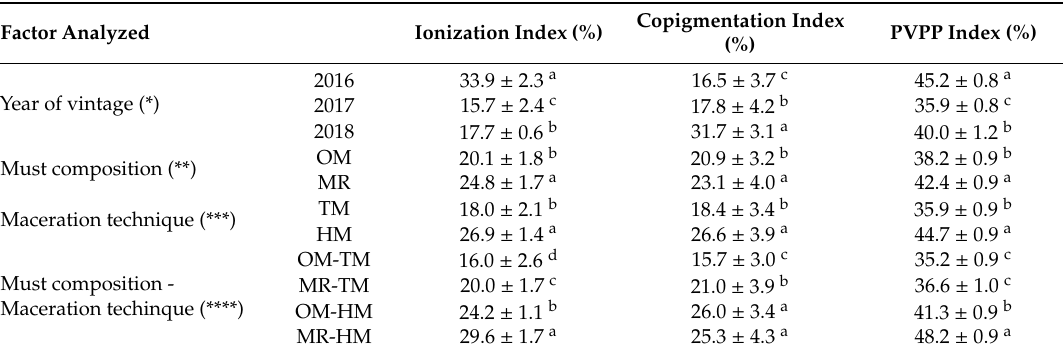
Table 3. Color fractions of the